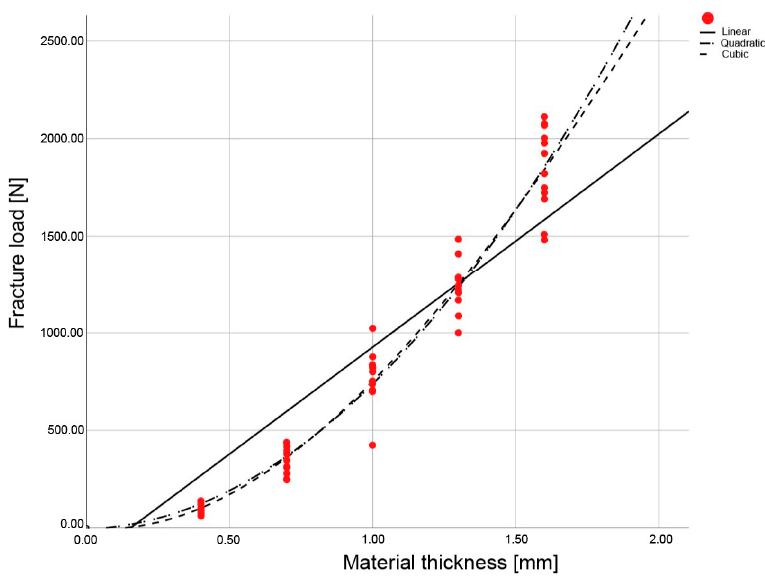
Figure 5. Regression curves of the fracture load values for the IPS e.max CAD LT A2 (EMX), with specimens in the five different material thicknesses examined.